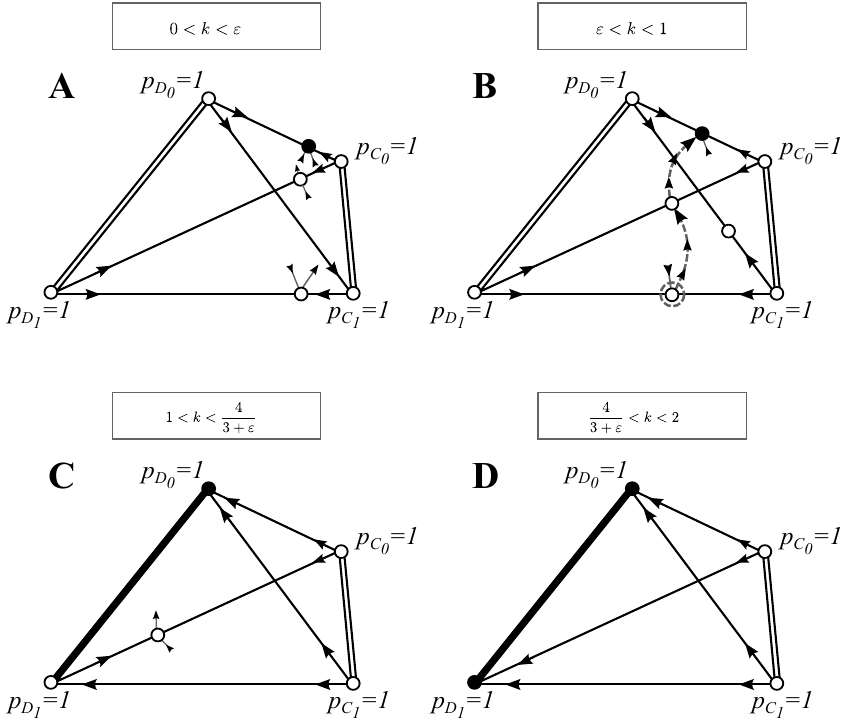
Figure 2. Phase-plane analysis for the model with imperfect signals: see Figure 1 for